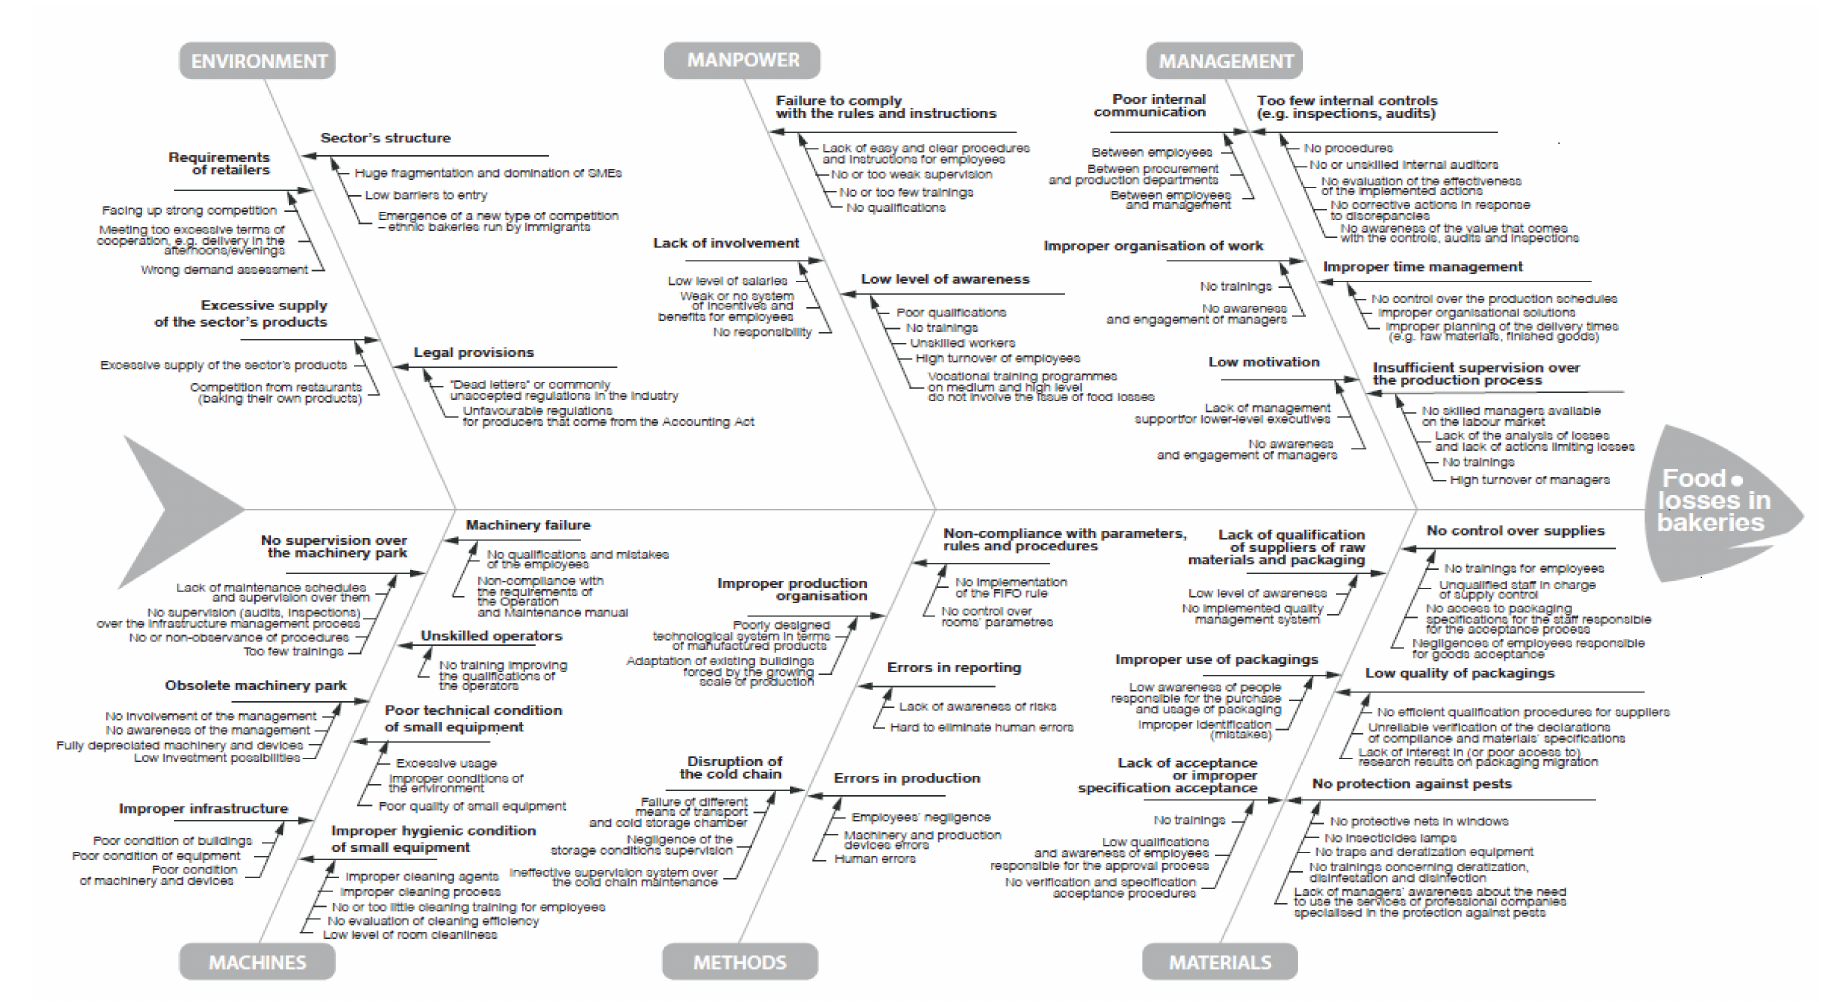
Figure 1. Cause-and-effect Ishikawa diagram of food losses in the baking and confectionery industry—results of own